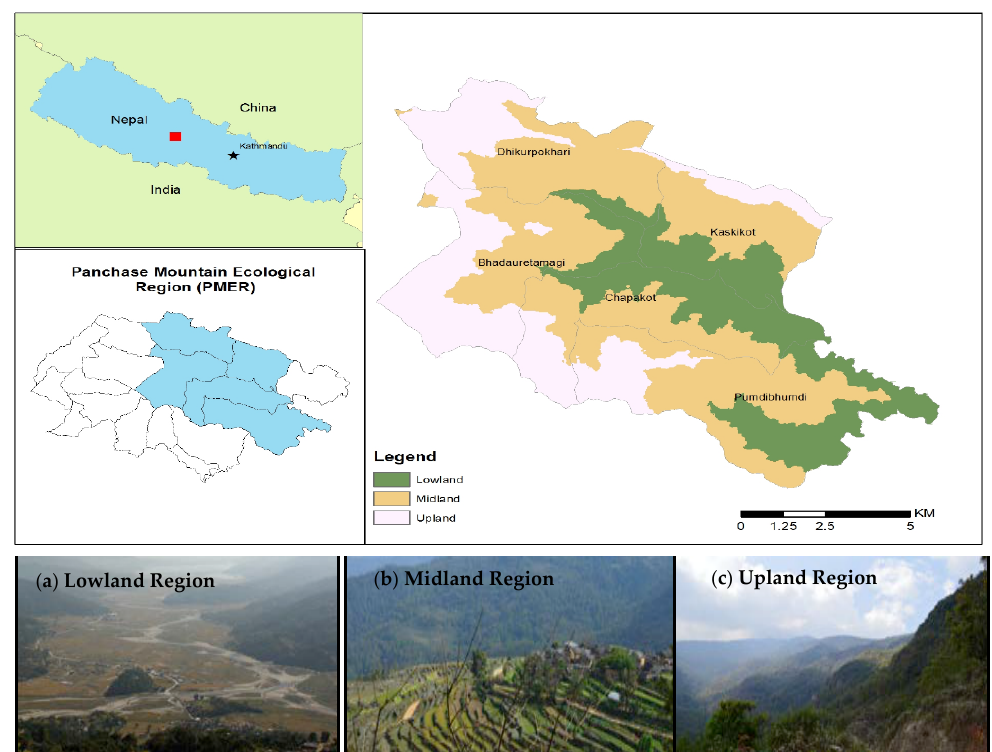
Figure 1. Map of study area in the Panchase Mountain Ecological Region, with lowland ( a ) midland ( b ), and upland ( c ) regions, based on altitudinal variation.